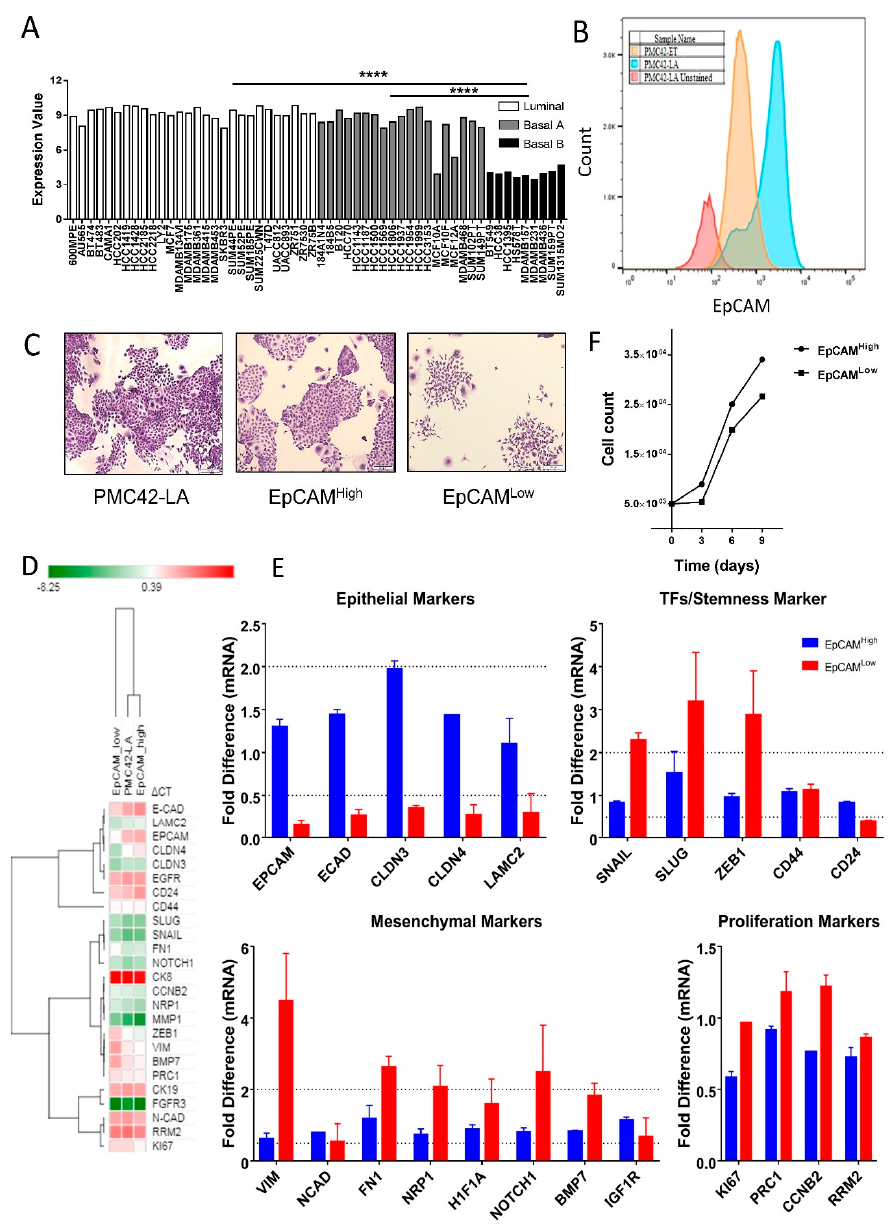
Figure 1. ( A ) EpCAM assessment in gene expression data of 50 breast cancer cell lines and five non-malignant breast cell lines, including three subtypes of luminal, basal A and basal B / mesenchymal. Data are from Array Express (accession no. E-MTAB-181) (Heiser et al., 2012) and are normalized log2-transformed values; **** P < 0.0001 (one-way ANOVA, with Tukey’s multiple comparisons). ( B ) Histogram plots depicting di ff erences in the surface levels of EpCAM protein across PMC42-ET and PMC42-LA cell lines. Negative control represents PMC42-LA unstained cells. The EpCAM expression is markedly low in the PMC42-ET parental cell line and the PMC42-LA cell line showed 15%–20% proportion of the population as EpCAM Low . ( C ) Crystal violet staining of the colony images of PMC42 LA population and its subpopulations to emphasize the distinct mesenchymal phenotype of the EpCAM Low subpopulation when grown sparsely. ( D ) Hierarchical clustering performed using the Morpheus (Gene-E tool) of the normalized ( ∆ Ct) values. ( E ) Gene expression analysis of 22 genes related to EMT markers and proliferation marker in EpCAM sorted subpopulations relative to expression in the parental (unsorted) PMC42-LA cell line. Data are represented as the mRNA fold di ff erence ± standard error of the mean (SEM) (Results are from n = 3 independent biological experiments). ( F ) Proliferation rate for EpCAM Low and EpCAM High subpopulations were evaluated by MTT assay (data are representative of n = 3 independent biological